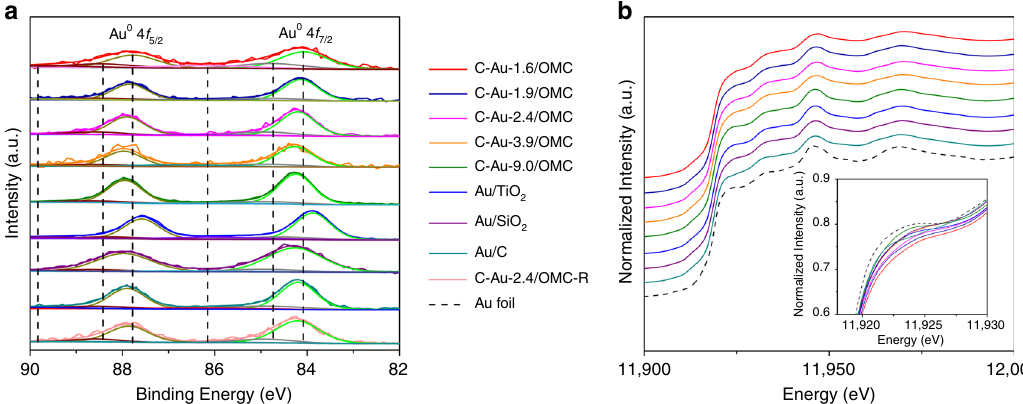
Fig. 2 Electronic properties. a XPS spectra of the Au 4 f level; and b XANES spectra of the Au L 3 -edge for Au nanocatalysts containing interstitial carbon supported on ordered mesoporous carbon. C – Au-2.4/OMC-R represents the catalyst after being used in fi ve runs. For comparison, commercial Au/TiO 2 , Au/SiO 2 , and Au/C were also